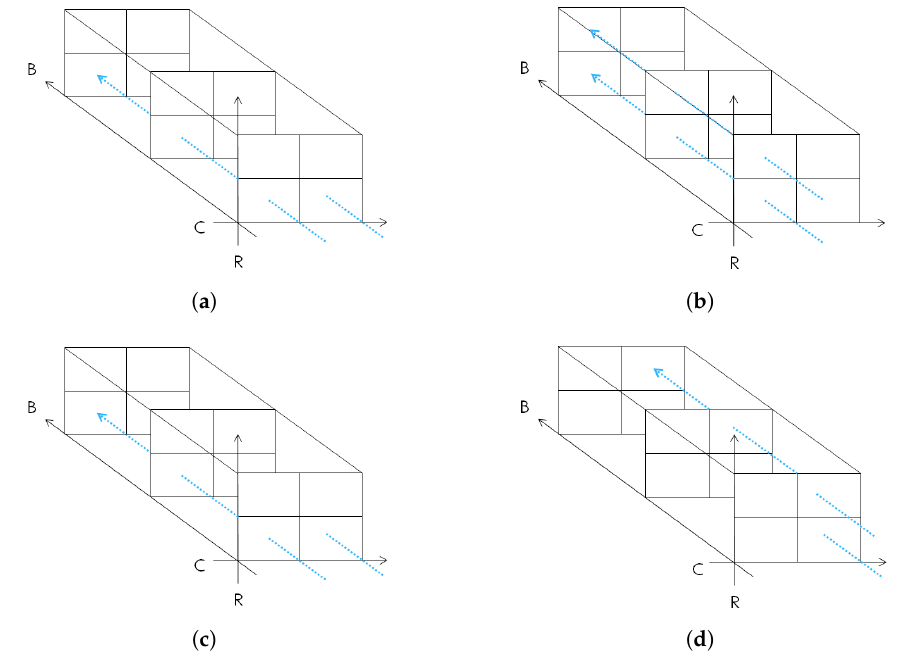
Figure 7. Ship loading rules’ searching flows. ( a ) Rule Lr 5 . ( b ) Rule Lr 6 . ( c ) Rule Lr 7 . ( d ) Rule Lr 8